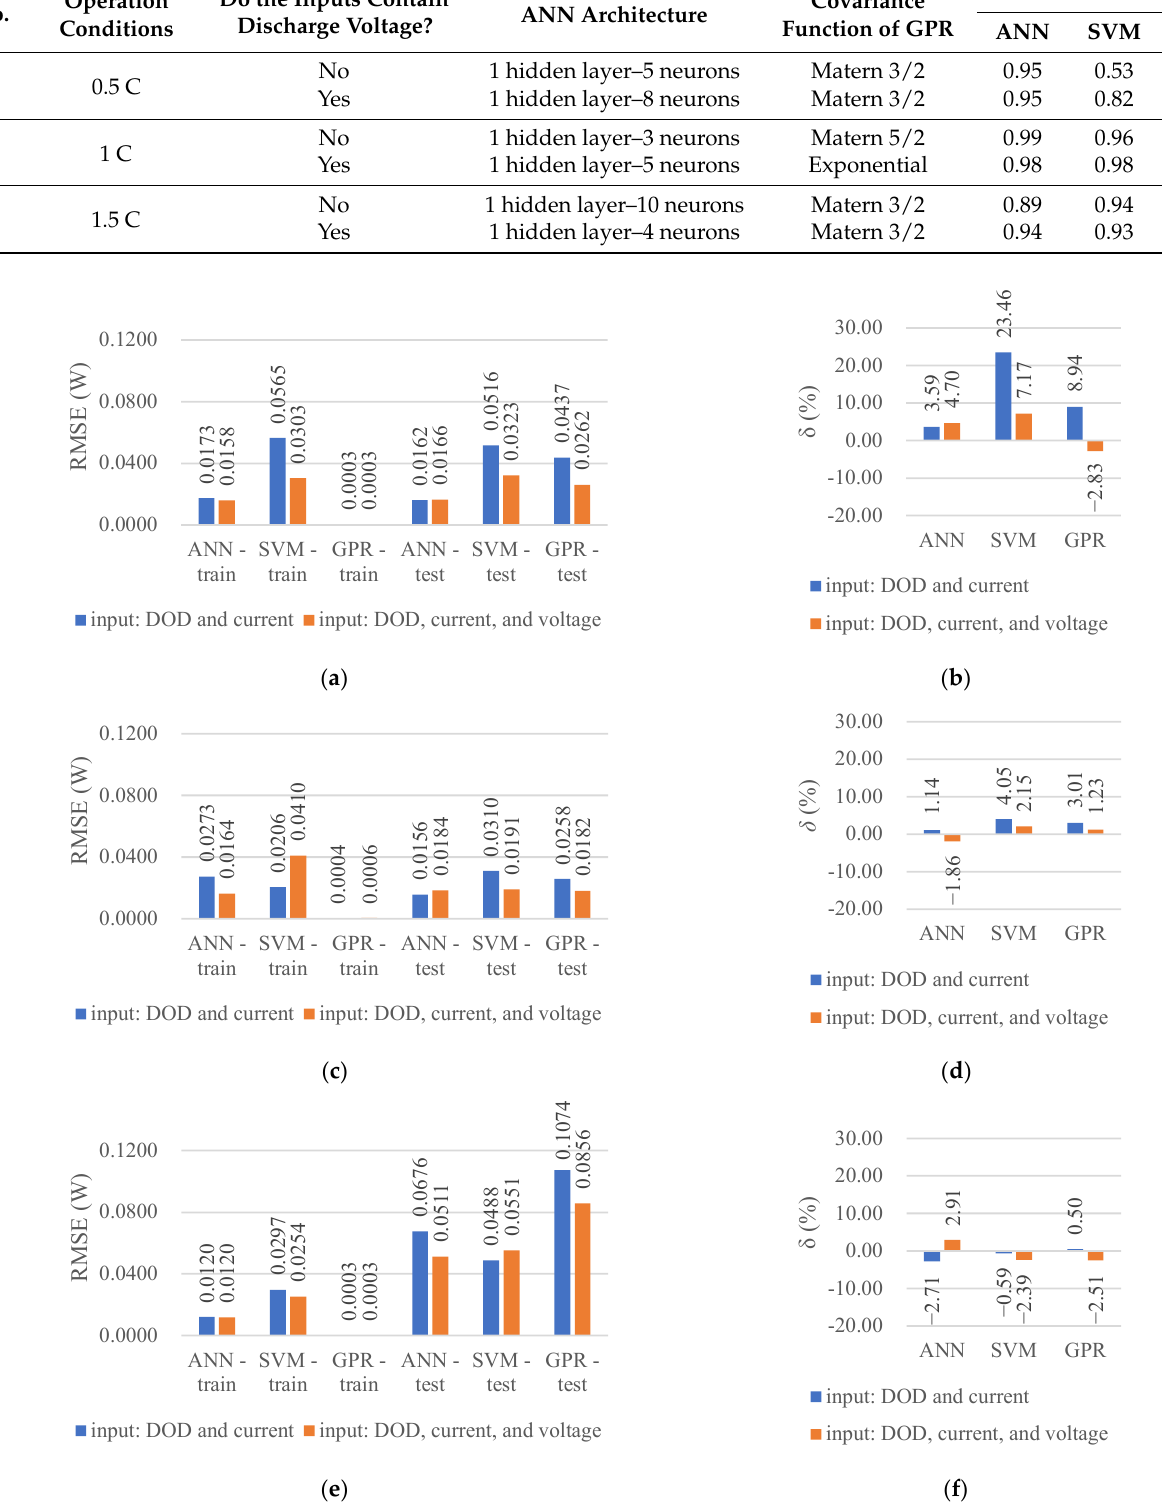
Figure 3. RMSE of training and testing, and the relative error of the average HGR, δ : ( a ) RMSE values of 0.5 C discharge; ( b ) δ of 0.5 C discharge; ( c ) RMSE values of 1 C discharge; ( d ) δ of 1 C discharge; ( e ) RMSE values of 1.5 C discharge; ( f ) δ of 1.5 C discharge.